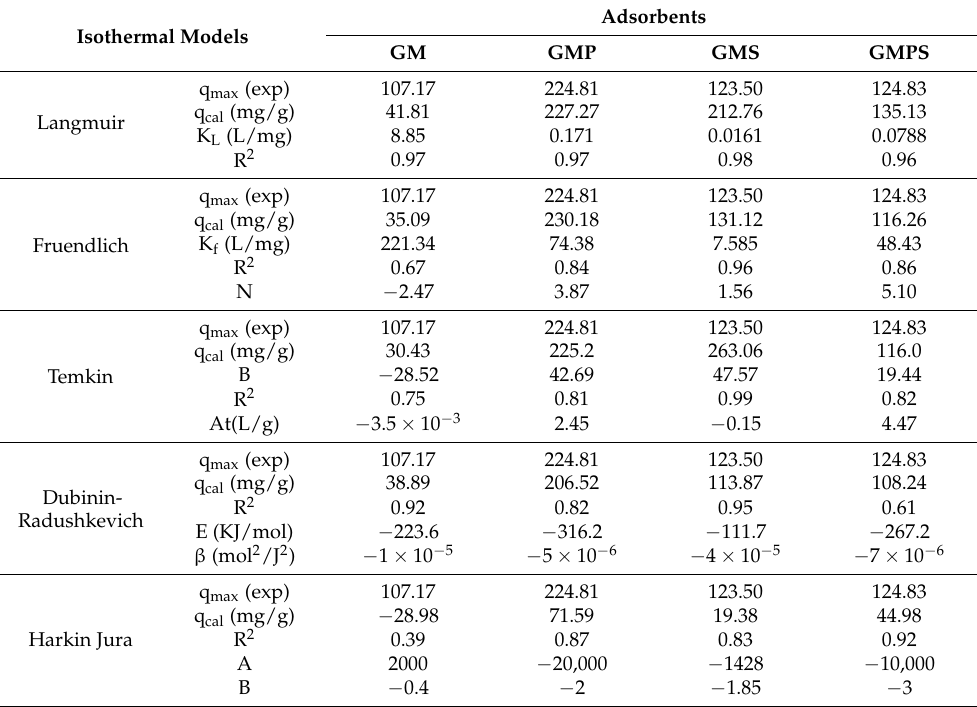
Table 3. Comparison of Langmuir, Fruendlich, Temkin, Dubinin-Radushkevich, and Harkin Jura isotherms for Foron red dye.